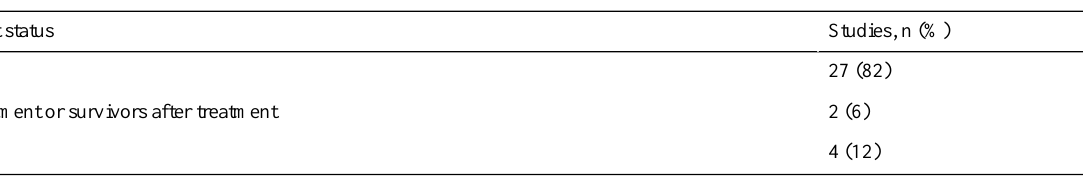
Table 2. Anticancer treatment status (N=33